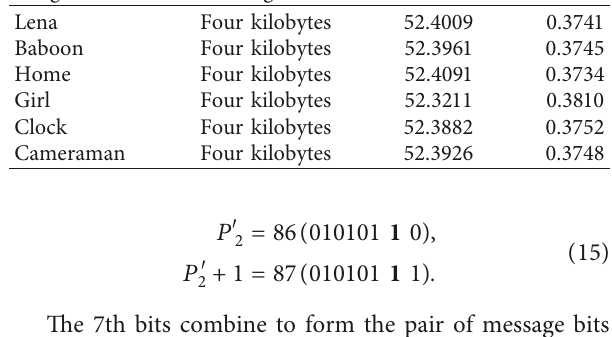
Table 5: Performance analysis of the proposed method using (256 256) ∗